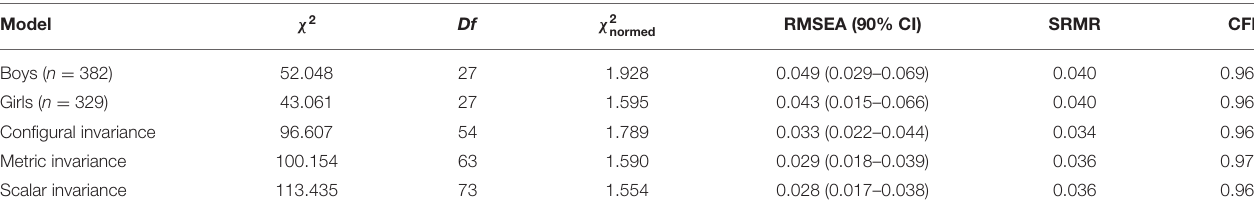
TABLE 1 | Model fit indices and tests of measurement invariance for the global SE factor across sex. Model χ 2 Df χ 2 normed RMSEA (90% CI)